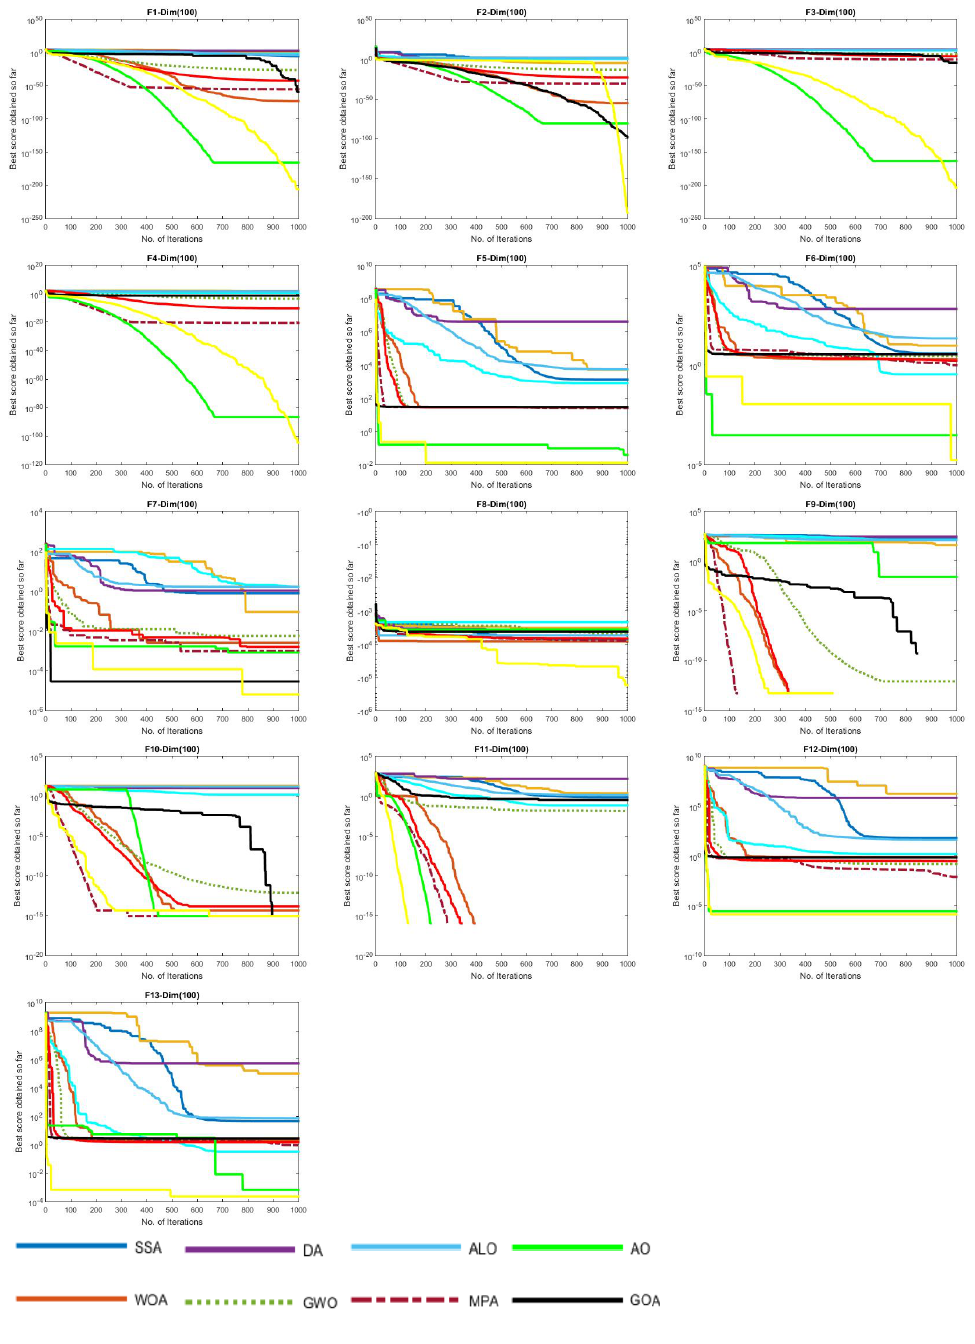
Figure 8. Convergence behaviors of the comparative algorithms on classical test functions (F1–F13) with higher dimensional sizes (i.e.,